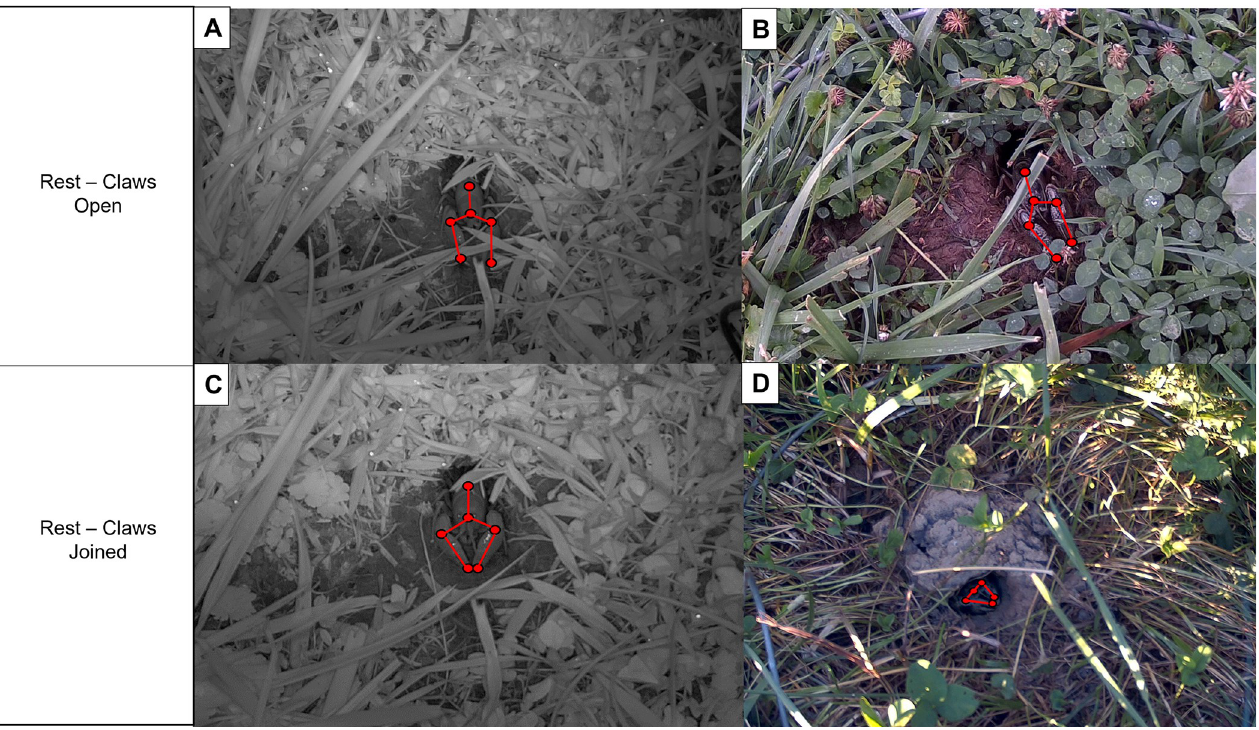
Fig 3. Example of rest–claws openand rest–claws joined behaviors from video surveys of Lacunicambarus thomai . The top two images (A) and (B) represent crayfish in the rest–claws open posture, whereas the bottom two image (C) and (D) represent the crayfish in the rest–claws joined posture. Red circles and red lines are presented to give a representation of the differences in articulation between the claws open and the claws joined postures. Photos (A) and (C) were taken at night, whereas photos (B) and (D) were taken during the day.